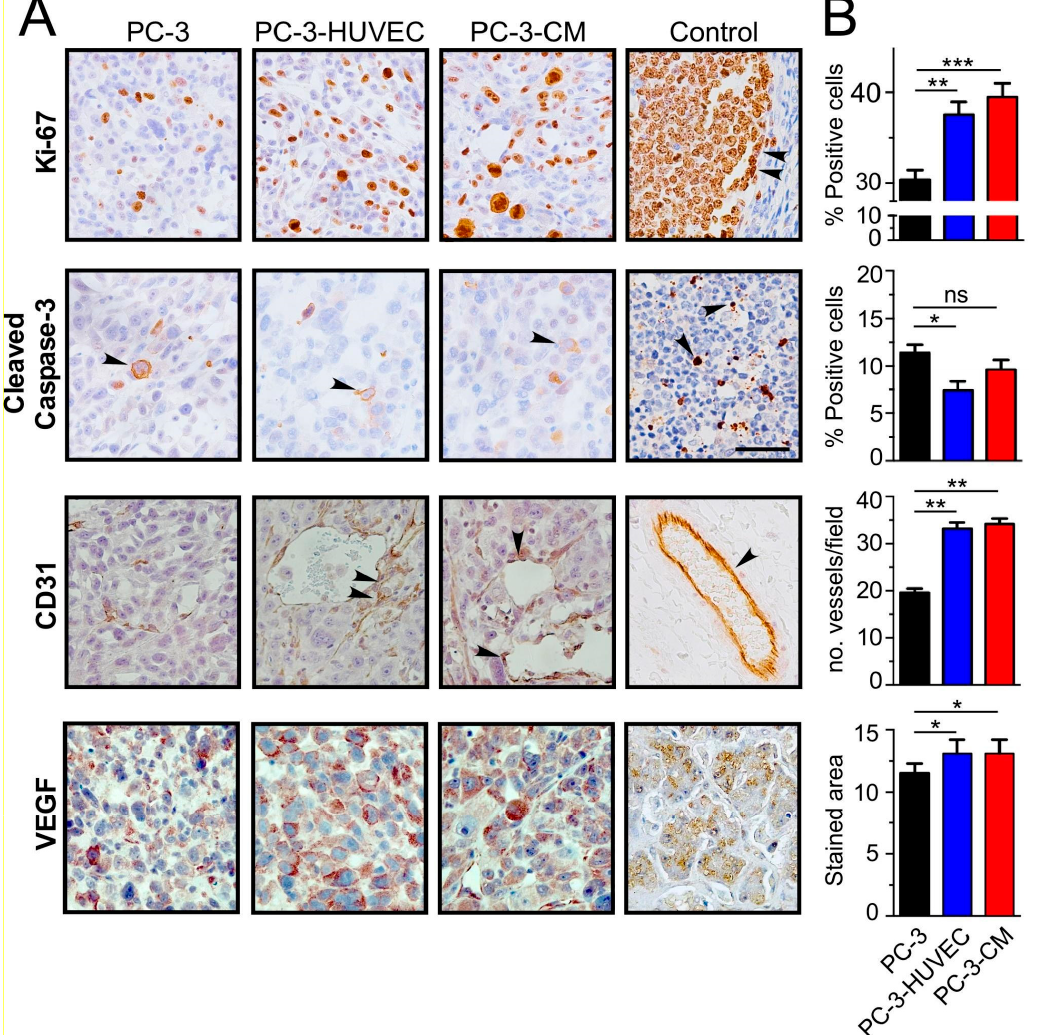
Figure 3. HUVEC-CM increases PCa proliferation and microvessel density in vivo. PC3 cells were injected subcutaneously alone (1 × 10 6 ), co-injected with HUVEC (5:1 PCa:HUVEC cells), or pre- incubated for 48 h with CM from HUVEC before injection in a mixture with Matrigel (1:1) for a total injection volume of 100 μ L. ( A ) Representative images of the immunohistochemical analysis of Ki- 67, cleaved caspase-3, CD31 and VEGF expression in tissue sections of PC-3 cell line-derived xeno- graft tumors. ( B ) Quantitation of the number of positive cells per field for Ki-67 and cleaved caspase- 3, number of vessels per field (CD31) and immunostained area (VEGF) in tissue sections of PC-3 cell-line-derived xenograft tumors was determined using ImageJ software. Positive controls for the expression of Ki-67 and cleaved caspase-3 were human tonsil, CD31 and VEGF, mouse adipose tis- sue, and human liver, respectively ( n = 8; * p ≤ 0.05, ** p ≤ 0.01, *** p ≤ 0.001 t -test) Values in mean ± SD. 3.4. Human Endothelial Cells Enhance Metastasis of PC-3 Cell-Line-Derived Xenograft Tumors The detection of metastatic foci in mouse tissues was achieved using the im- munostaining analyses of Ki-67 of human origin (Figure 4A). The incidence of total me- tastasis (sum of all organs) was slightly higher from tumors of PC-3 cells pre-treated with HUVEC-CM or PC-3 cells co-injected with HUVEC when compared to tumors of PC-3 alone (Figure 4B). Furthermore, when the incidence of metastasis was analyzed in indi-